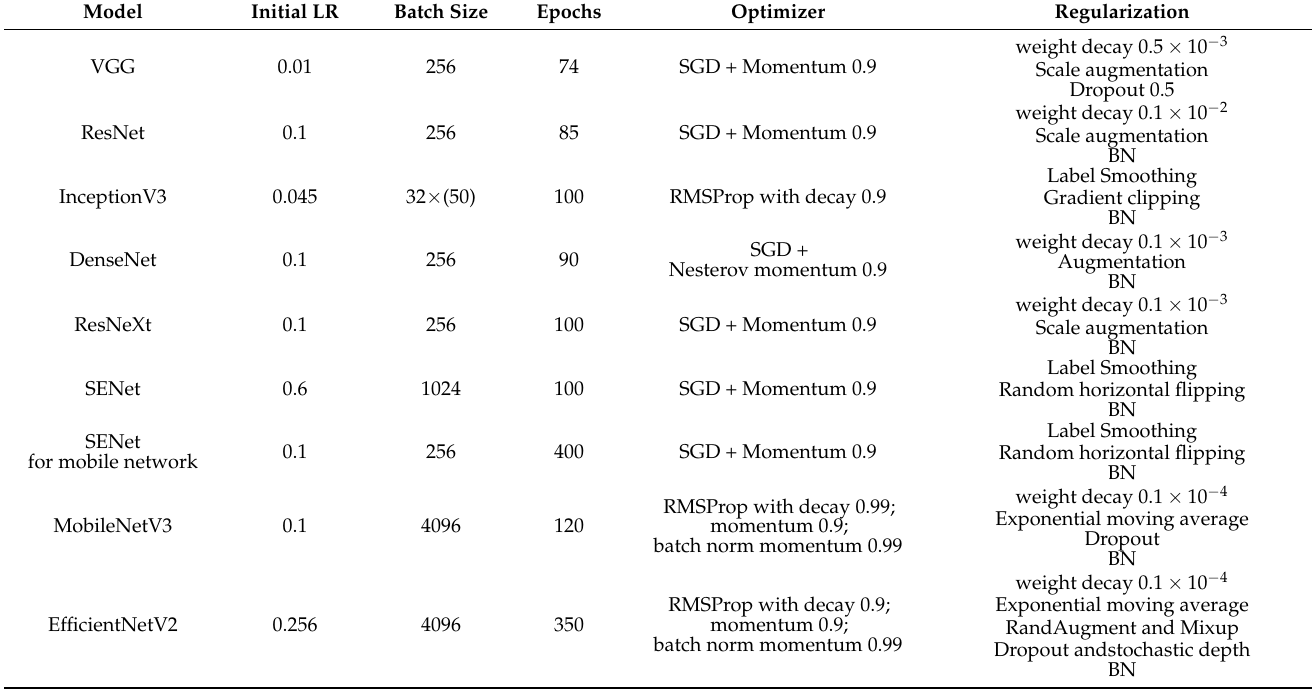
Table 5. Model settings during training. ‘32 × (50)’ indicates that the distributed machine learning system using 50 replicas running each on a GPU with batch size